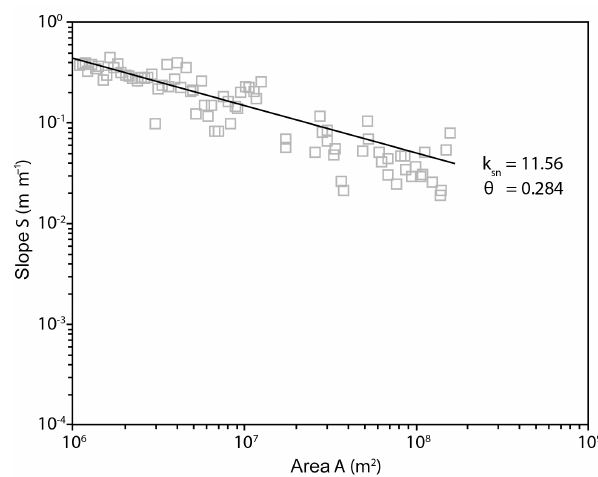
Figure 4. Exemplary plot showing the linear regression of the log- arithmic slope–area plot, from which the two variables θ and k s can be